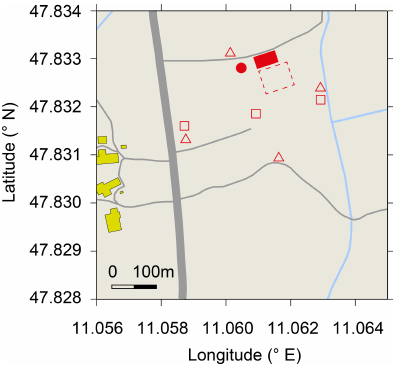
Figure 1. Map of research site De-Fen with nearby farm buildings (yellow), streets and country lanes (grey) , ditches (blue), the mobile laboratory (filled red square), 2m sample inlet for TREX-QCLAS measurements, (red dot), area of flux chambers and soil water con- tent measurements (dashed red square), precipitation gauges (open triangles), and location of PT-100 sensors (open squares). © Open- StreetMap contributors 2019. Distributed under a Creative Com- mons BY-SA